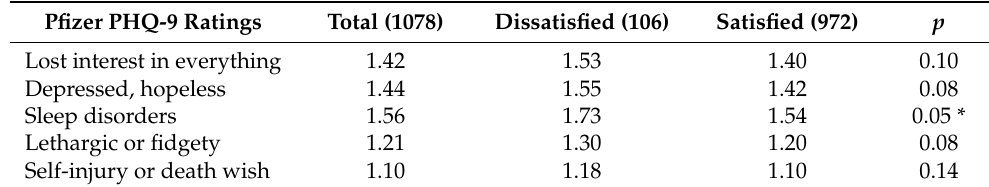
Table 3. Public Health Scale differences between dissatisfied and satisfied